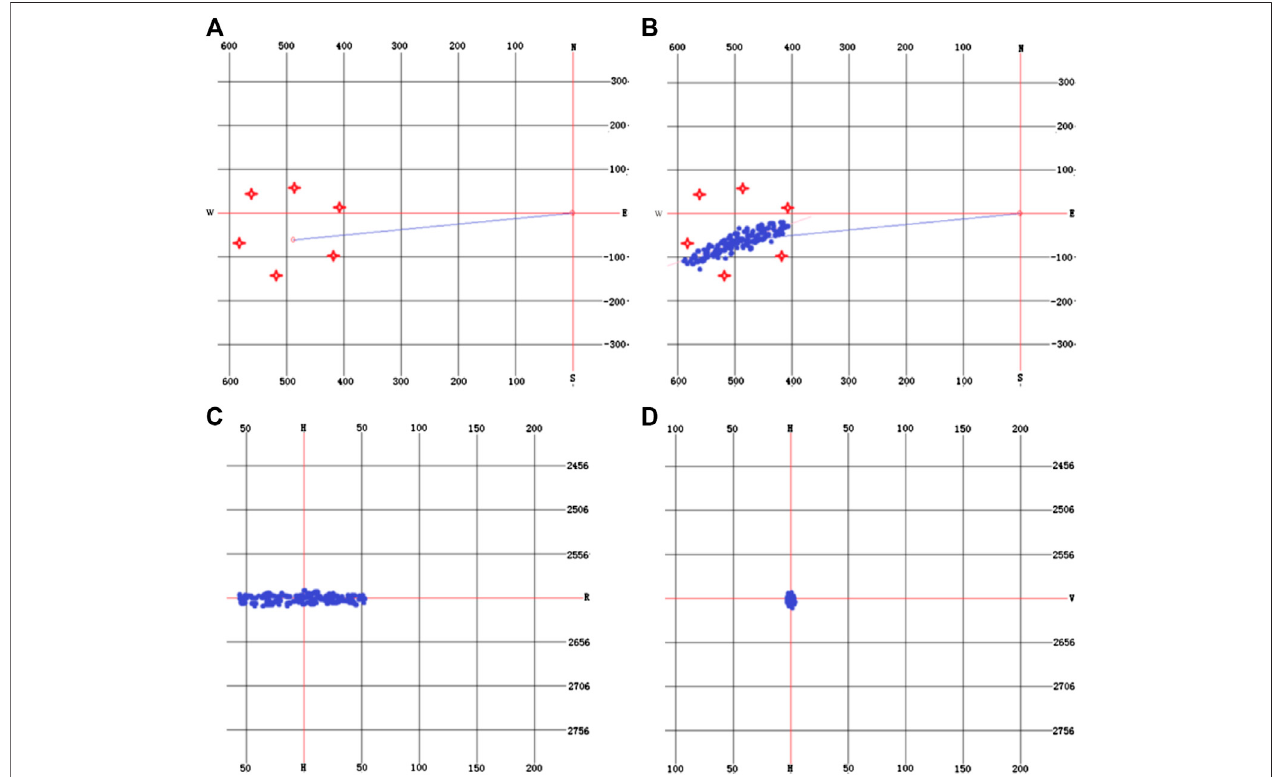
FIGURE7| MicroseismicfracturedetectioninWellX4-1.Notes: (A) Distributionofmonitoringstationsaroundthewell; (B) Fractureorientation; (C) Fracturelength; (D) Fracture occurrence.